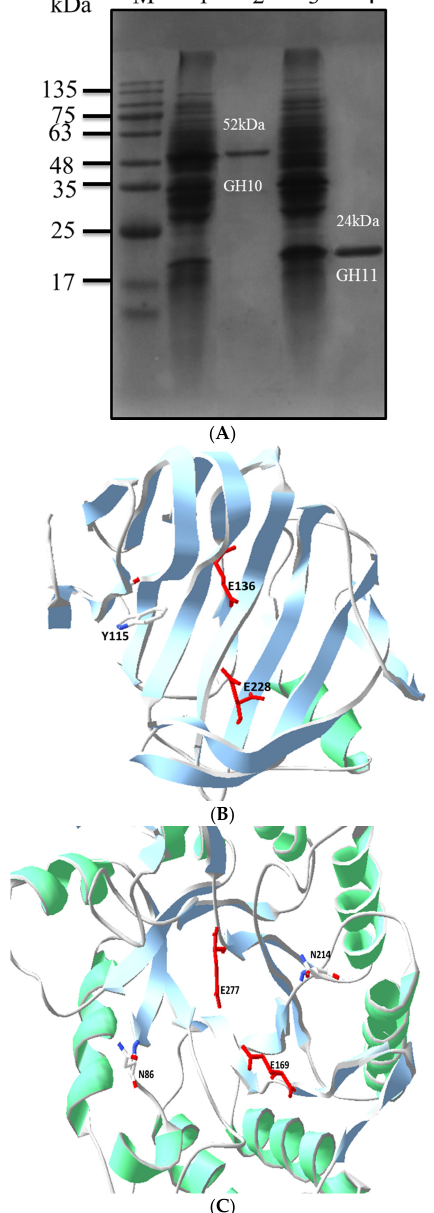
Figure 3. The SDS and Modeling locations of the enzyme. ( A ) The SDS of crude and purified enzyme. M: Mark, Channel 1: crude enzyme of GH10-xyn, Channel 2: purified enzyme of GH10-xyn, Channel